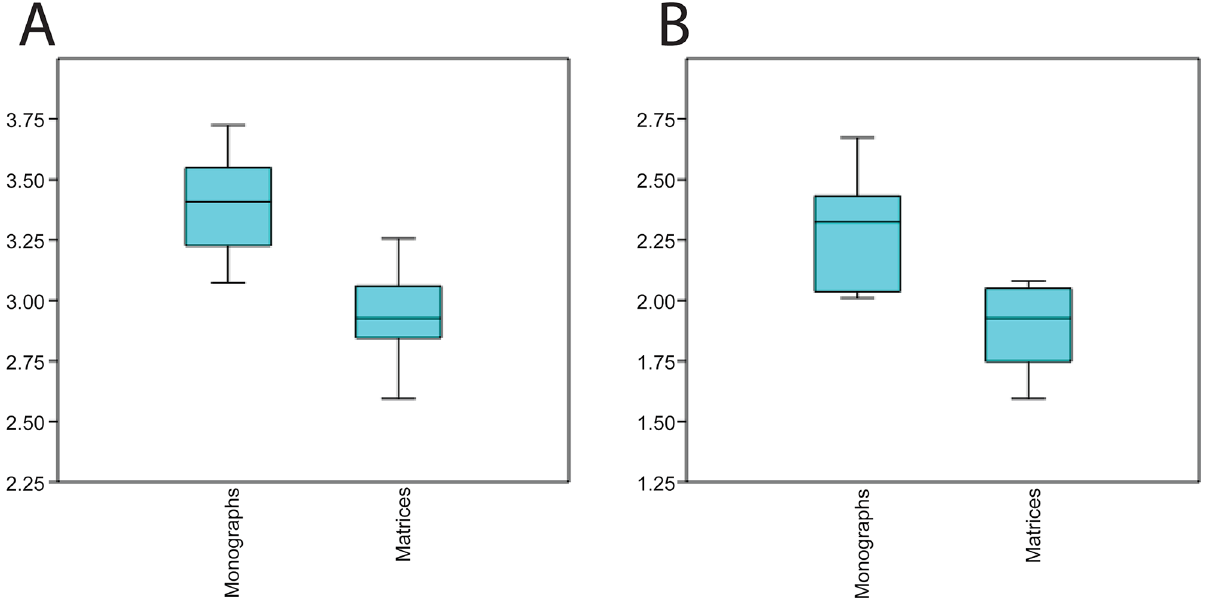
Fig 1. Boxplots showing comparison of mean EQ (A) and E (B) size per annotation between monographs and matrices. See Table 2 for details. Comparison of quality size was not included as there was no significant difference between mean quality complexity between the two sources of data (t-test p = 0.18). Breakdown of types per publication shown in S2 Appendix.